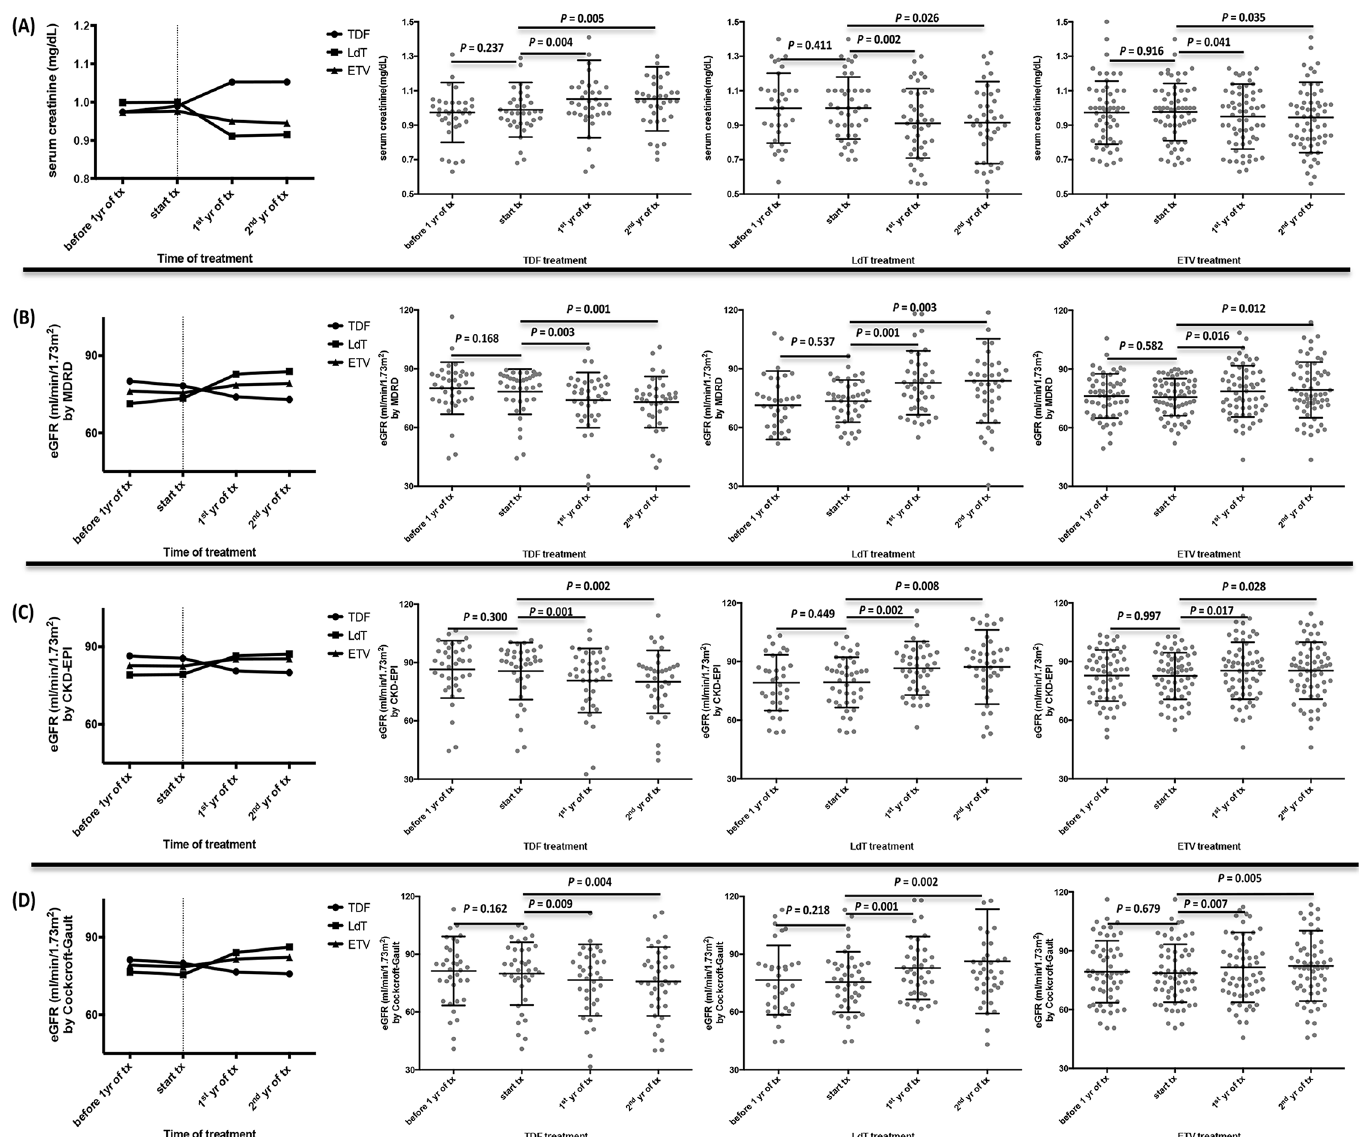
Fig 2. Changes of renal function-associated indicators among tenofovir, telbivudine and entecavir groups before and after treatment. (A) by serum creatinine (B) eGFR calculated by MDRD (C) eGFR calculated by CKD-EPI (D) eGFR calculated by Cockcroft-Gault. Horizontal bar indicates mean levels with standard